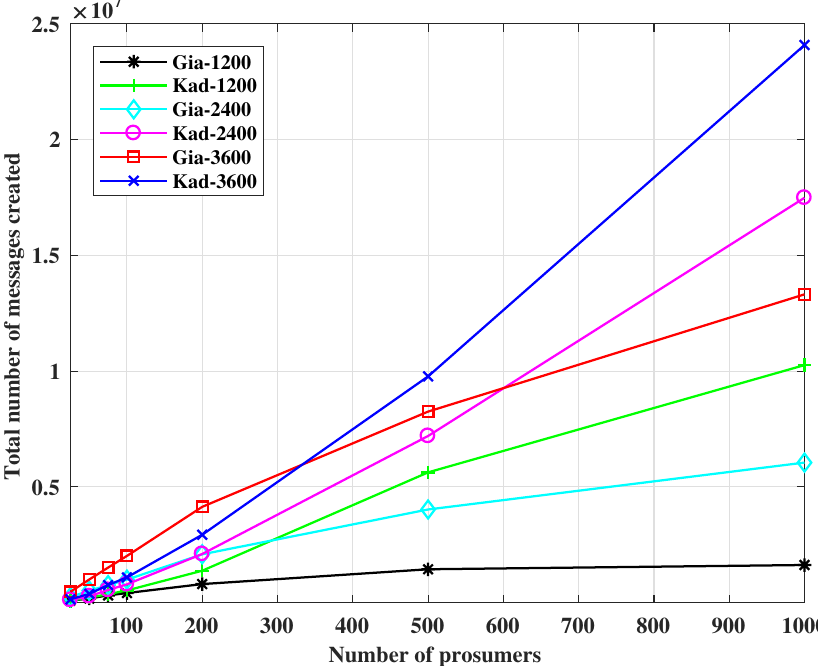
Figure 6. Number of messages created as the activity period and number of prosumers increases.